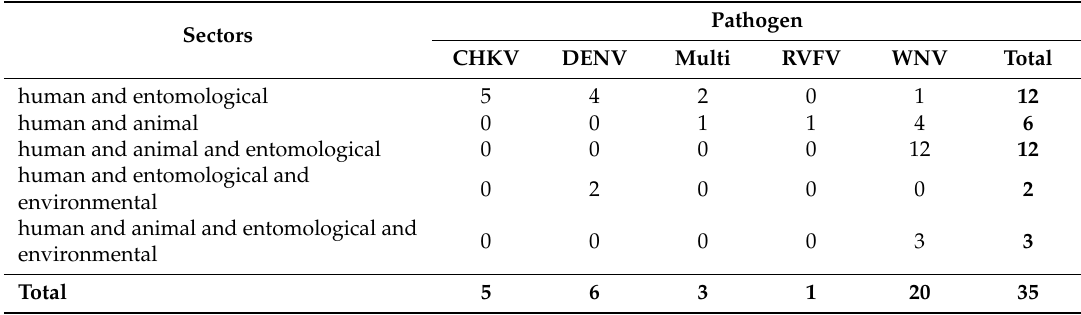
Table 4. The number of articles reporting on the number and type of sectors integrated in surveillance, by pathogen.